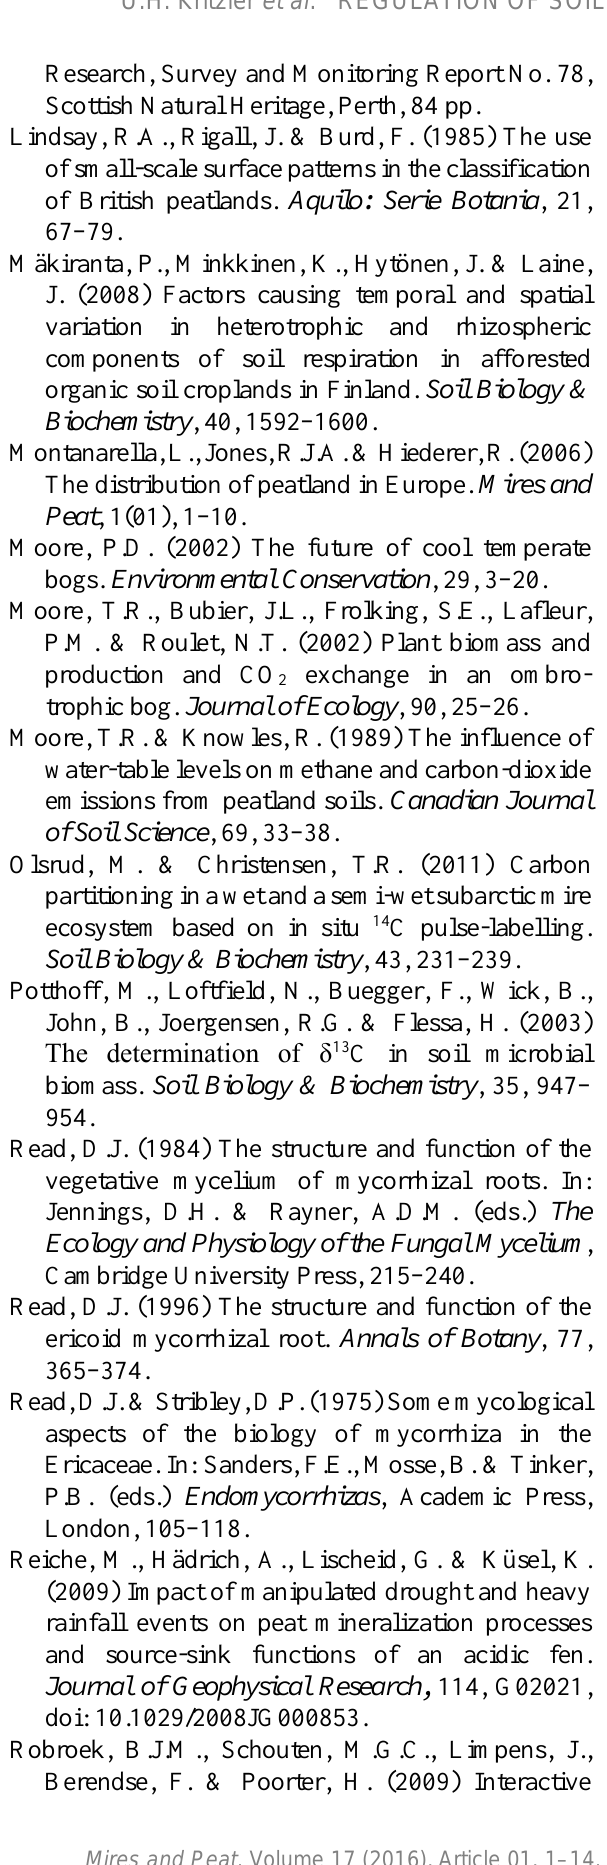
table. Global Change Biology, 15,